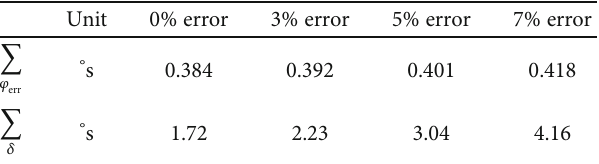
Table 5: Performance